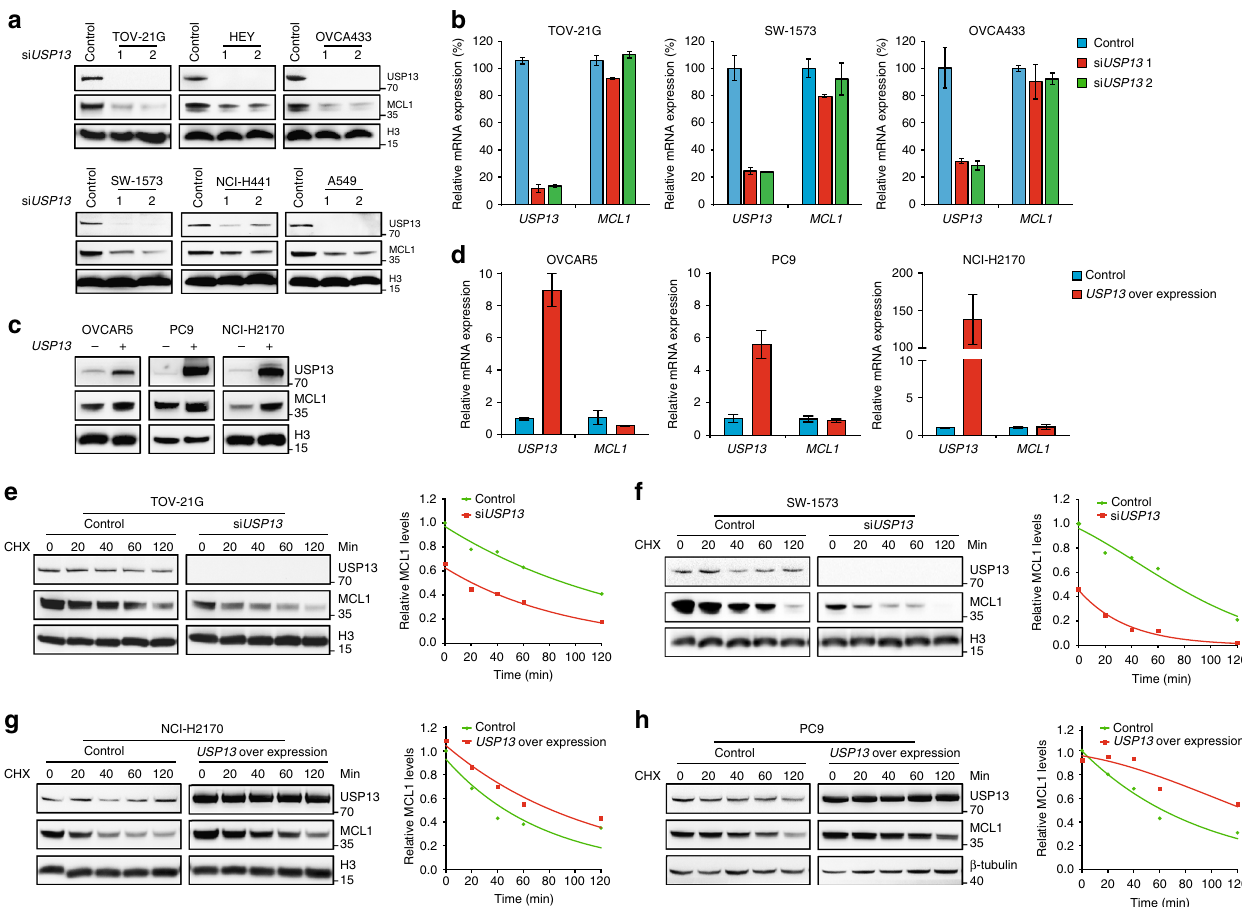
Fig. 3 USP13 promotes MCL1 protein stability. a USP13 knockdown by siRNAs decreased MCL1 protein levels in human ovarian cancer (TOV-21G, HEY and OVCA433) and lung cancer (SW-1573, NCI-H441 and A549) cell lines. b Quantitative PCR analysis of USP13 and MCL1 mRNA levels in TOV-21G, SW-1573 and OVCA433 cells upon USP13 knockdown (* P < 0.05, Student ’ s t -test). The gene expression levels were normalized to GAPDH , and error bars indicated standard deviation (each condition contained three biological replicates). c Lentiviral USP13 overexpression increased MCL1 protein levels in human ovarian cancer (OVCAR5) and lung cancer (PC9 and NCI-H2170) cell lines. d Quantitative PCR analysis of USP13 and MCL1 mRNA levels in OVCAR5, PC9 and NCI-H2170 cells upon USP13 overexpression (* P < 0.05, Student ’ s t -test). The gene expression levels were normalized to GAPDH , and error bars indicated standard deviation (each condition contained three biological replicates). e , f Left: TOV-21G or SW-1573 cells were transfected with USP13 siRNAs, treated with 20 µ g/mL CHX, collected at different time points and then immunoblotted with antibodies against indicated proteins. Right: quanti fi cation of MCL1 protein levels (normalized to H3) at different time points. g , h Left: PC9 and NCI-H2170 cells were transduced with lentiviral vector overexpressing USP13 , treated with 20 µ g/mL CHX, collected at different time points and then immunoblotted with antibodies against indicated proteins. Right: quanti fi cation of MCL1 protein levels (normalized to H3 or β -tubulin) at different time